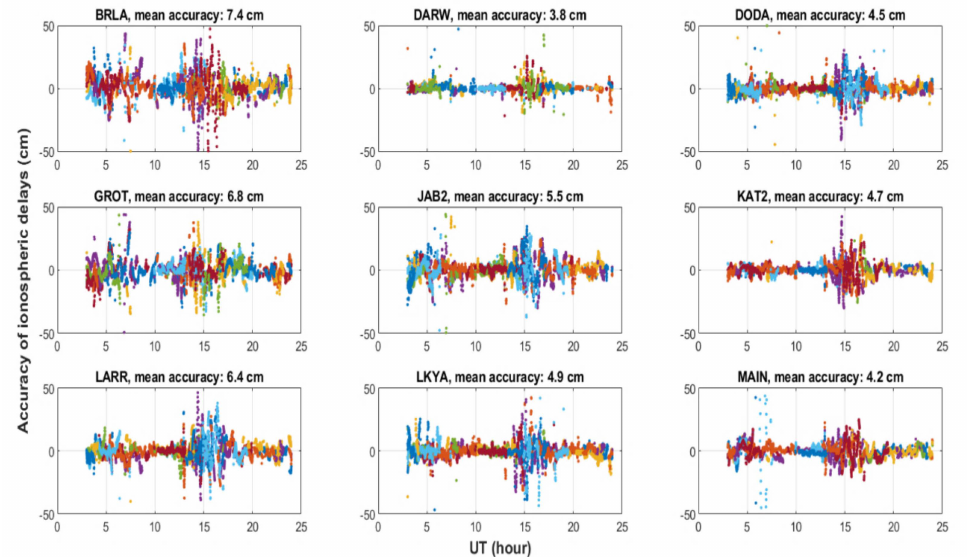
Figure 8. Plots showing the differences between the interpolated and measured ionospheric correc- tions as function of time at the nine NT CORS GNSS stations on 6 May 2021. This figure is the same as Figure 7, but the y-axis scale is decreased from 5 m to 50